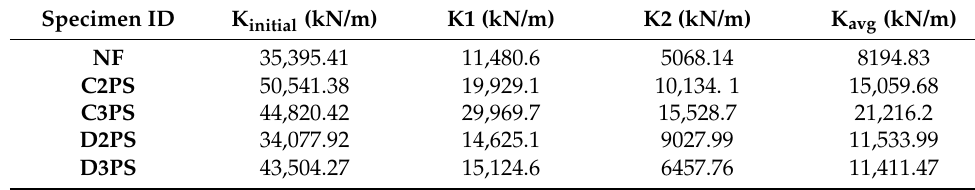
Figure 11. Average stiffness of tested specimens. Table 5. Stiffness for tested specimens.